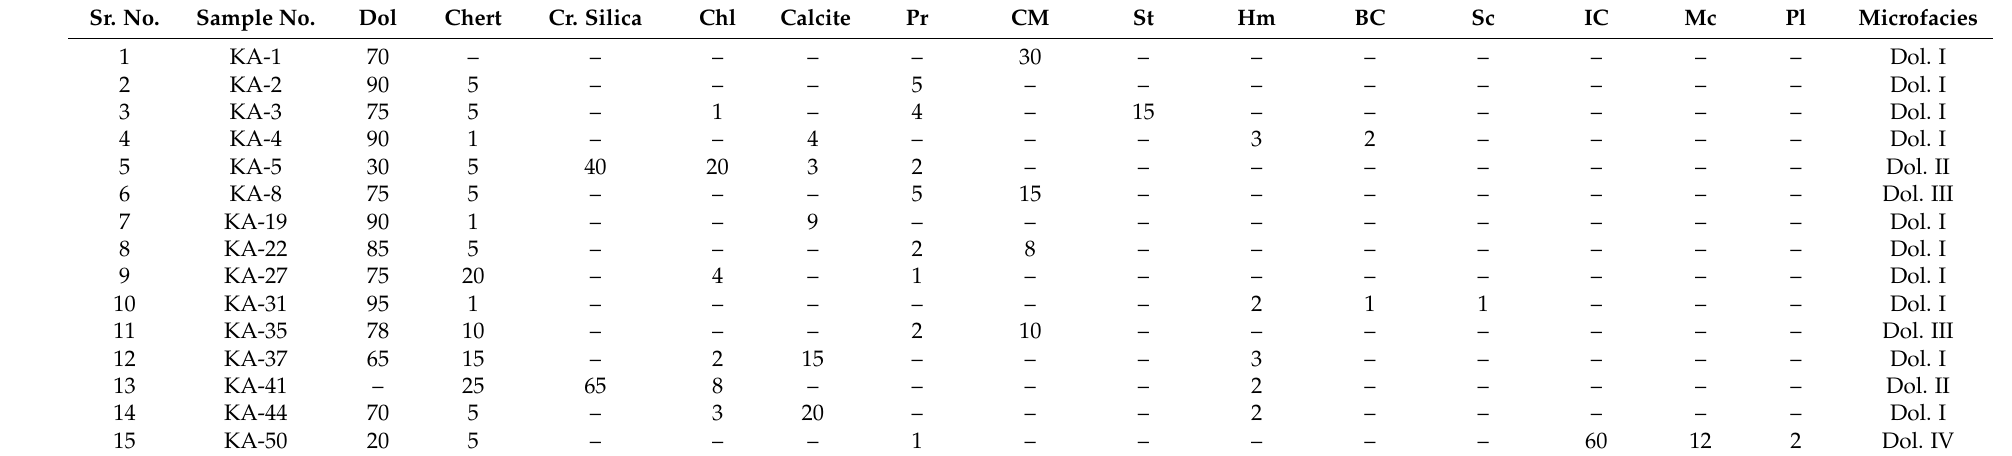
Table 2. Modal mineralogical composition of the Abbottabad Formation, Kamsar section, Muzaffarabad. Sr.